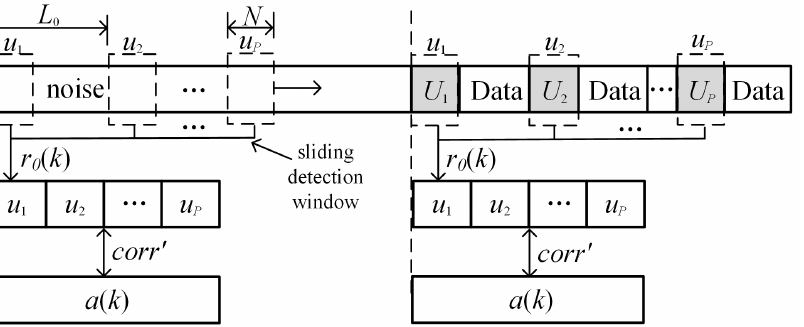
Figure 5. DUW burst signal detection principle.